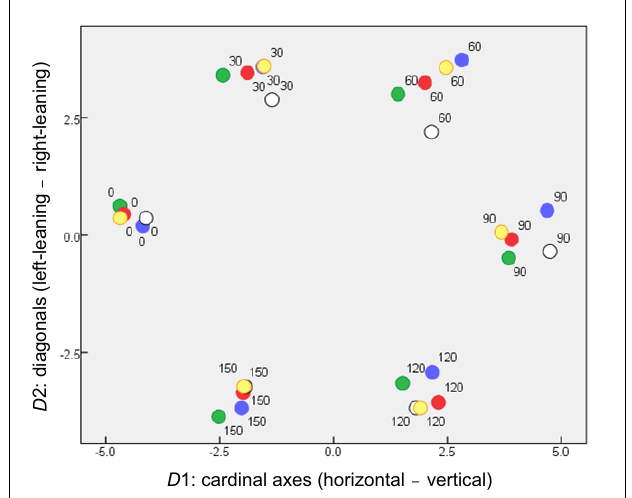
FIGURE 3 | Locations of stimuli in the orientation subspace of MDS solution (coordinates on D 1 and D 2), where symbols are coded according to stimulus